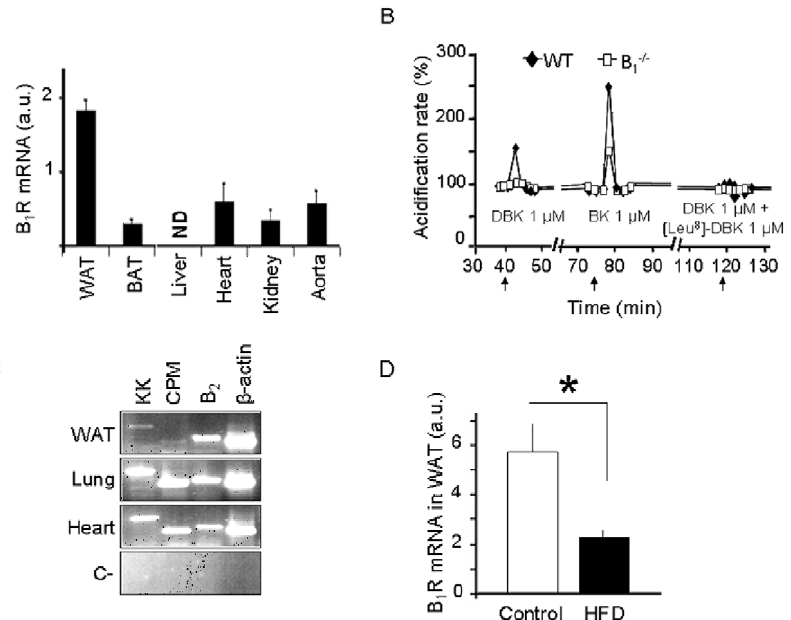
Figure 1. The kinin B 1 R is constitutively expressed in WAT and downregulated with obesity. A: Kinin B 1 R mRNA expression was quantified in different organs of male C57Bl/6 mice ( n =5) using TaqMan real-time PCR. Data are expressed as mean 6 SEM of the 2 2 D Ct parameter, which represents the relative expression of B 1 R mRNA in relation to b -actin mRNA. WAT, white adipose tissue; ND, non-detectable; a.u., arbitrary units. B: Effects of acute treatment with the B 1 R agonist des-Arg 9 -bradykinin (DBK), the B 2 receptor agonist bradykinin (BK) or DBK in the presence of the B 1 R antagonist [Leu 8 ]-DBK on the extracellular acidification rate of isolated adipocytes from wild type (WT) and B 1 knockout (B 1 2 / 2 ) mice ( n =5 animals per group) measured using the Cytosensor system. C: Representative RT-PCR showing expression of components of the kallikrein kinin system kallikrein in WAT, lung, and heart of C57Bl/6 male ( n =3). KK, tissue kallikrein; CPM, carboxypeptidase M; B 2 , kinin B 2 receptor. C-, negative control. D: C57BL/6 mice were submitted to HFD for 9 weeks ( n =5 per group). Kinin B 1 R expression was quantified in WAT by real time PCR. Results are mean 6 SEM. *, P , 0.05.